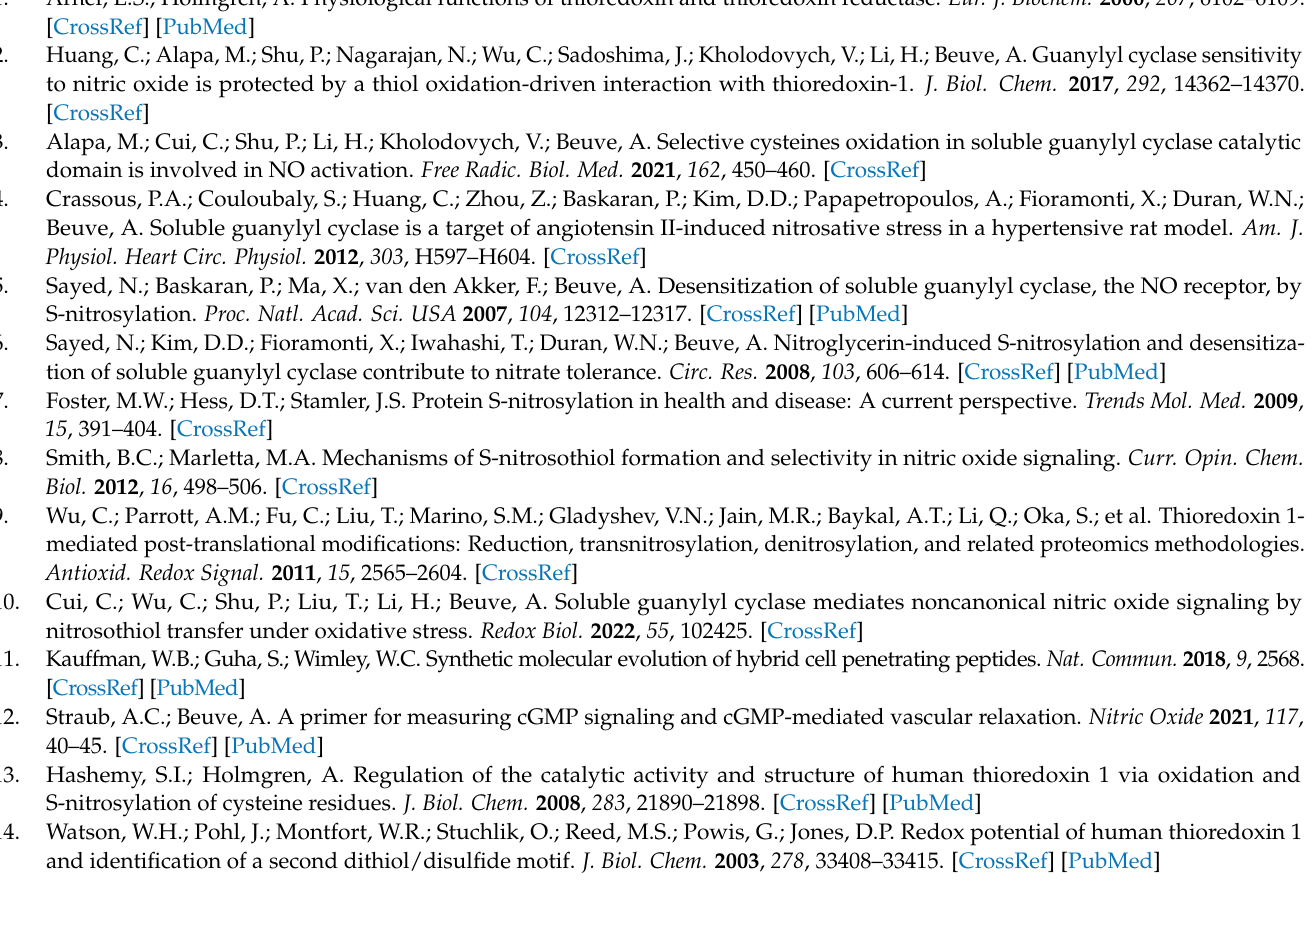
Figure S7: Uncropped Western blots from Figure 3A; Figure S8: Input of Jurkat cells used as starting material for biotin/avidin switch assay of Figure 4; Figure S9: Uncropped Western blot and Ponceau red stained blot from Figure